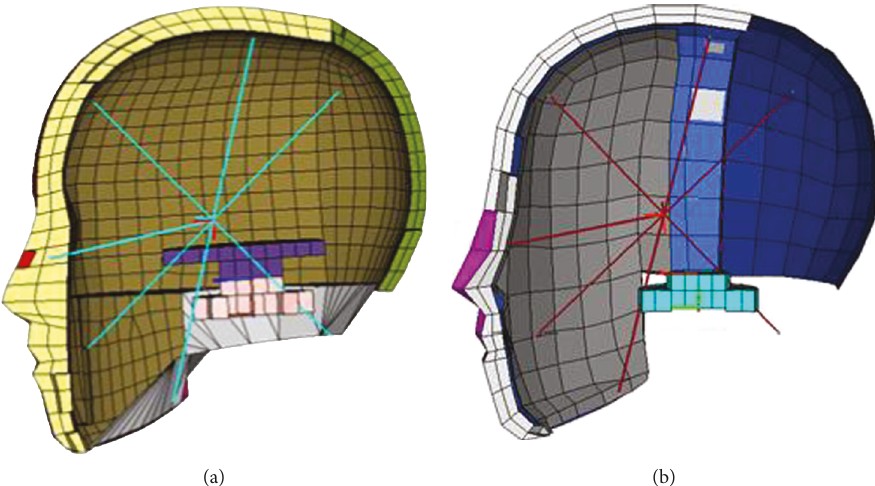
Figure 7: Detailed FE models of Hybrid III 50th and the simpli fi ed head structure.